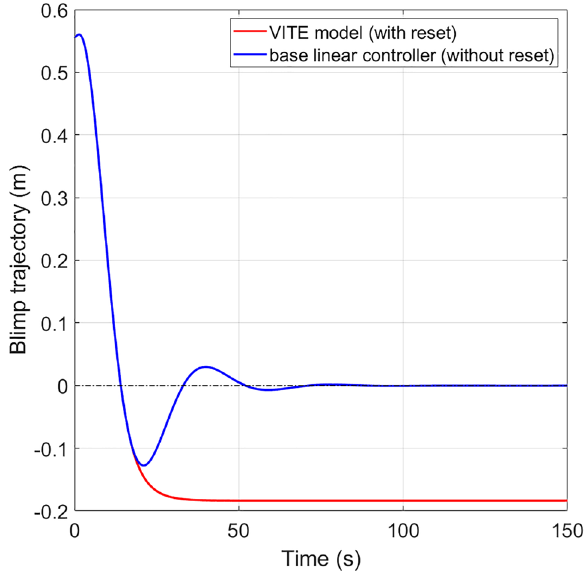
Figure 6. Simulated blimp trajectory under the base controller without the reset operation, and the VITE model. The initial position and velocity of the blimp are identical from the experiment, and the parameters of the VITE model are identified from dataset